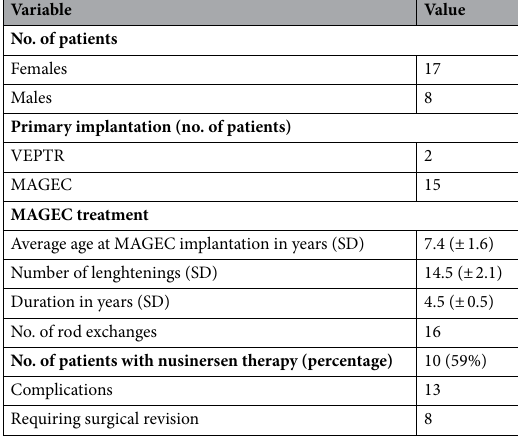
Table 1. Patient demographics.